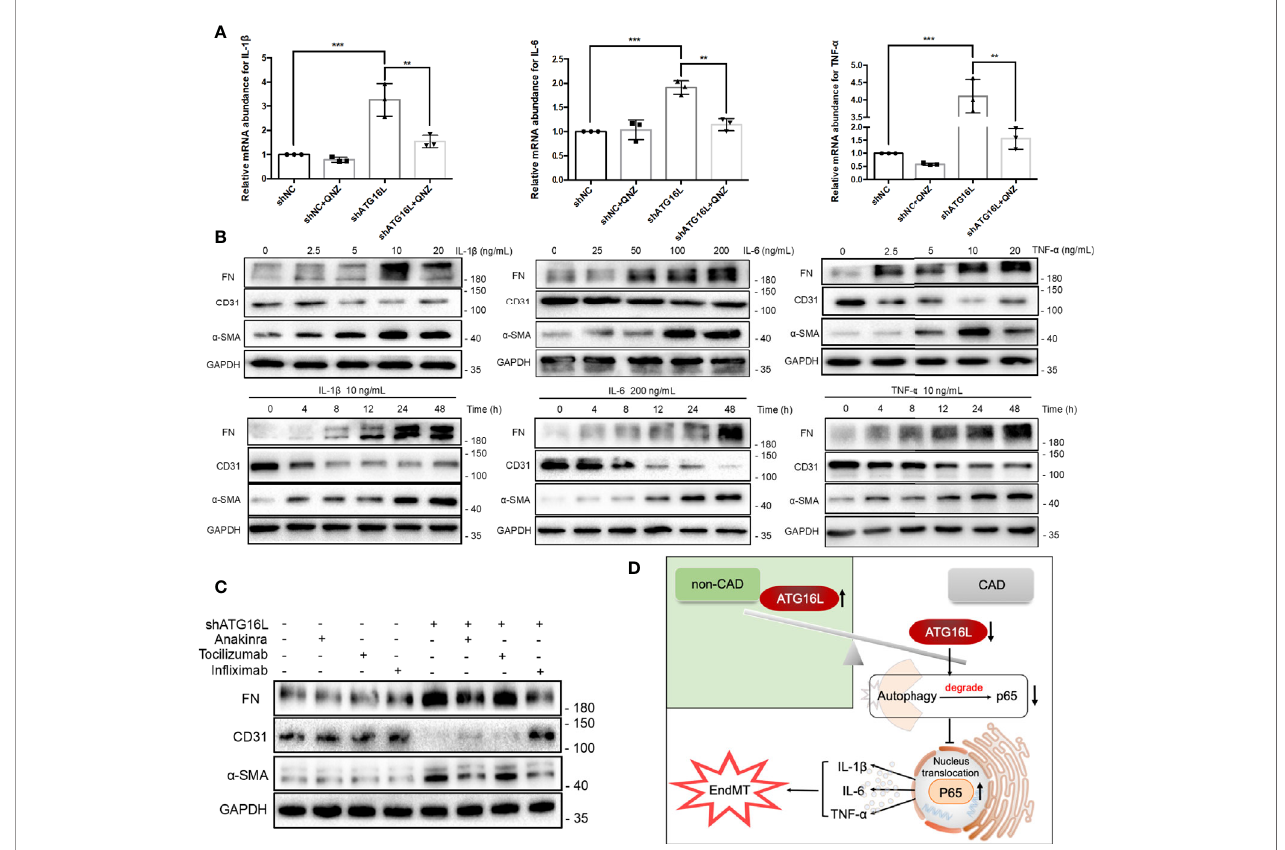
FIGURE 8 | Cytokines induced by NF- k B pathway activation and effects on progression of EndMT in HRGECs. (A) The graphs of the results of mRNA abundance of IL-1 b , IL-6 or TNF ‐ a after knocking down ATG16L with or without QNZ. (n = 5, *** P < 0.001, ** P < 0.01, vs. the shNC group, Student t test.) (B) Representative western blotting results of the expressions of FN, CD31, a -SMA and GAPDH in HRGECs after IL-1 b , IL-6 or TNF- a treatment for different times or dosage. (n=5) (C) Representative western blot results of FN, CD31, a -SMA and GAPDH expressions treated with or without Anakinra, Tocilizumab and In fl iximab in HRGECs transfected with shATG16L or not. (n=5) (D) A model is proposed to illustrate the mechanisms involved in EndMT induced by loss of ATG16L in the pathogenesis of CAD and transplanted renal interstitial fi